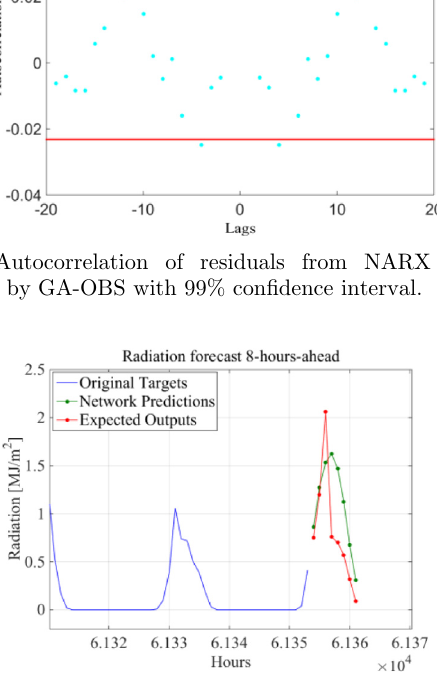
Fig. 6. 8-h-ahead solar irradiation forecast with the NARX network optimized by GA-OBS.